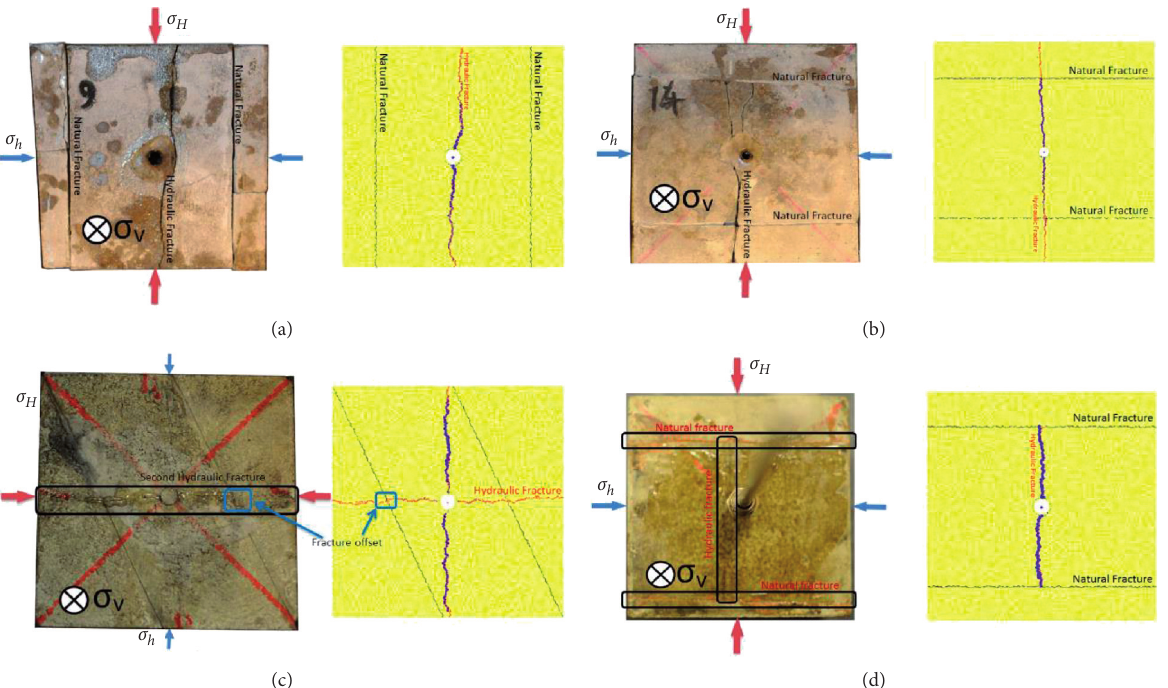
Figure 10: Photos and schematic of experimentally observed interaction forms between hydraulic fracture and preexisting fracture [48]. (a) No interaction. (b) Crossing without offset. (c) Crossing with offset. (d)